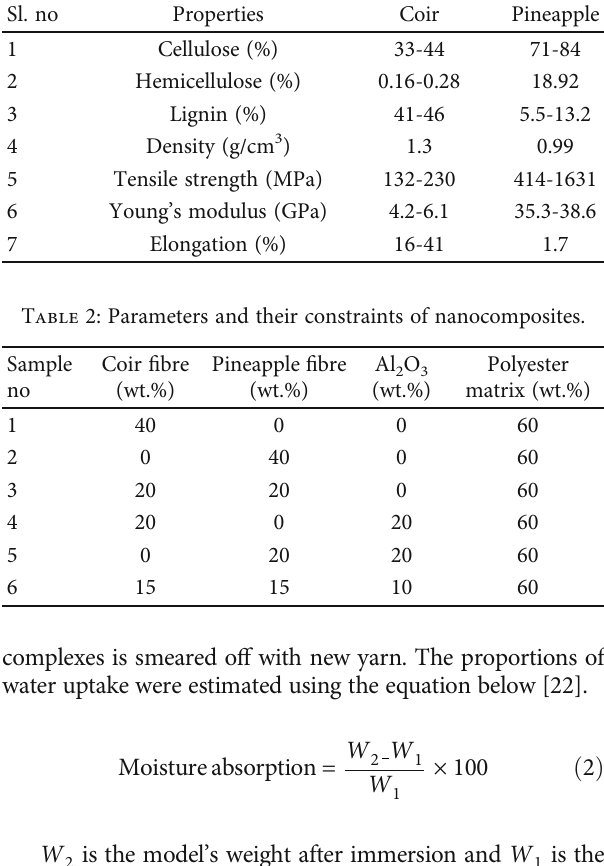
Figure 1: Photographic images of matrix, coir fi bre, pineapple fi bres, and nano-Al Table 1: Mechanical possessions of coir and pineapple leaf fi bre. Sl. no Properties Coir Pineapple